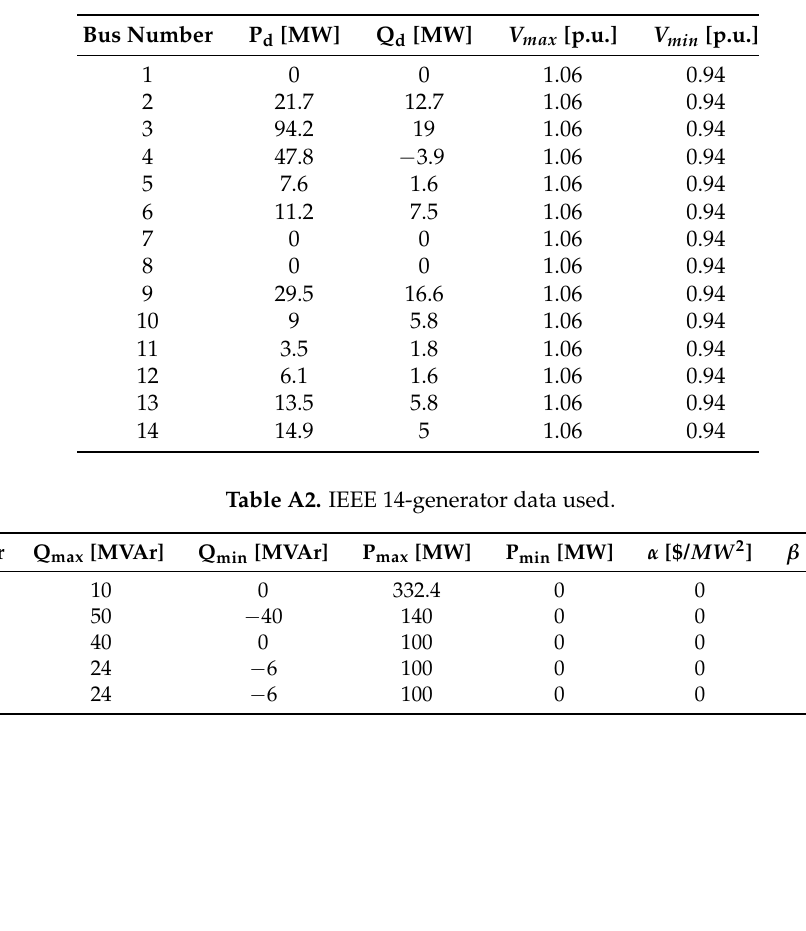
Table A1. IEEE 14-bus data used.